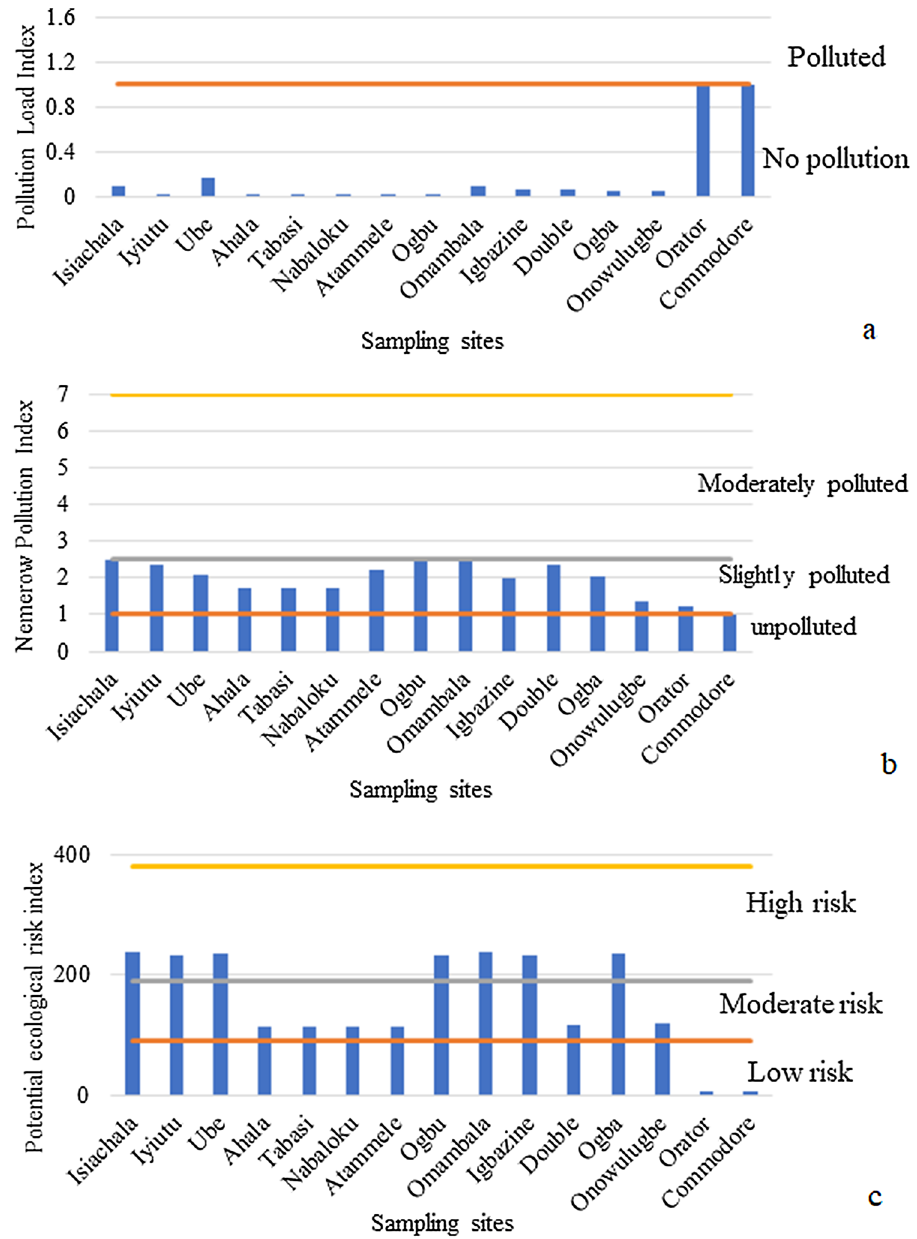
Fig. 8 Multi-elemental indices of heavy metals in water samples, a pollution load index (PLI), b nemerow pollution index (NPI) and c potential ecological risk index